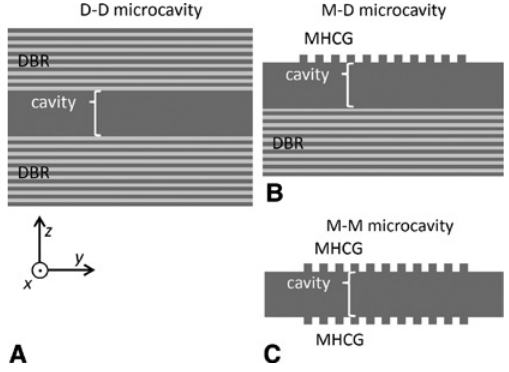
Figure 1: Schematic cross-section of microcavities concerned in the